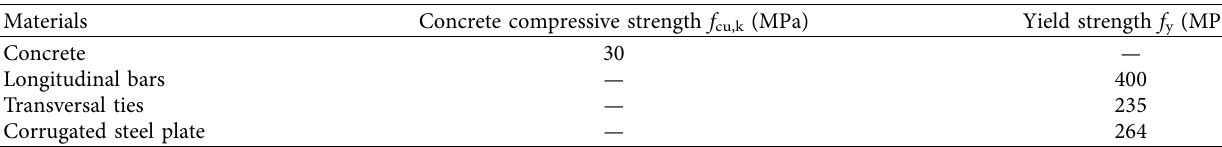
Table 1: Material properties.